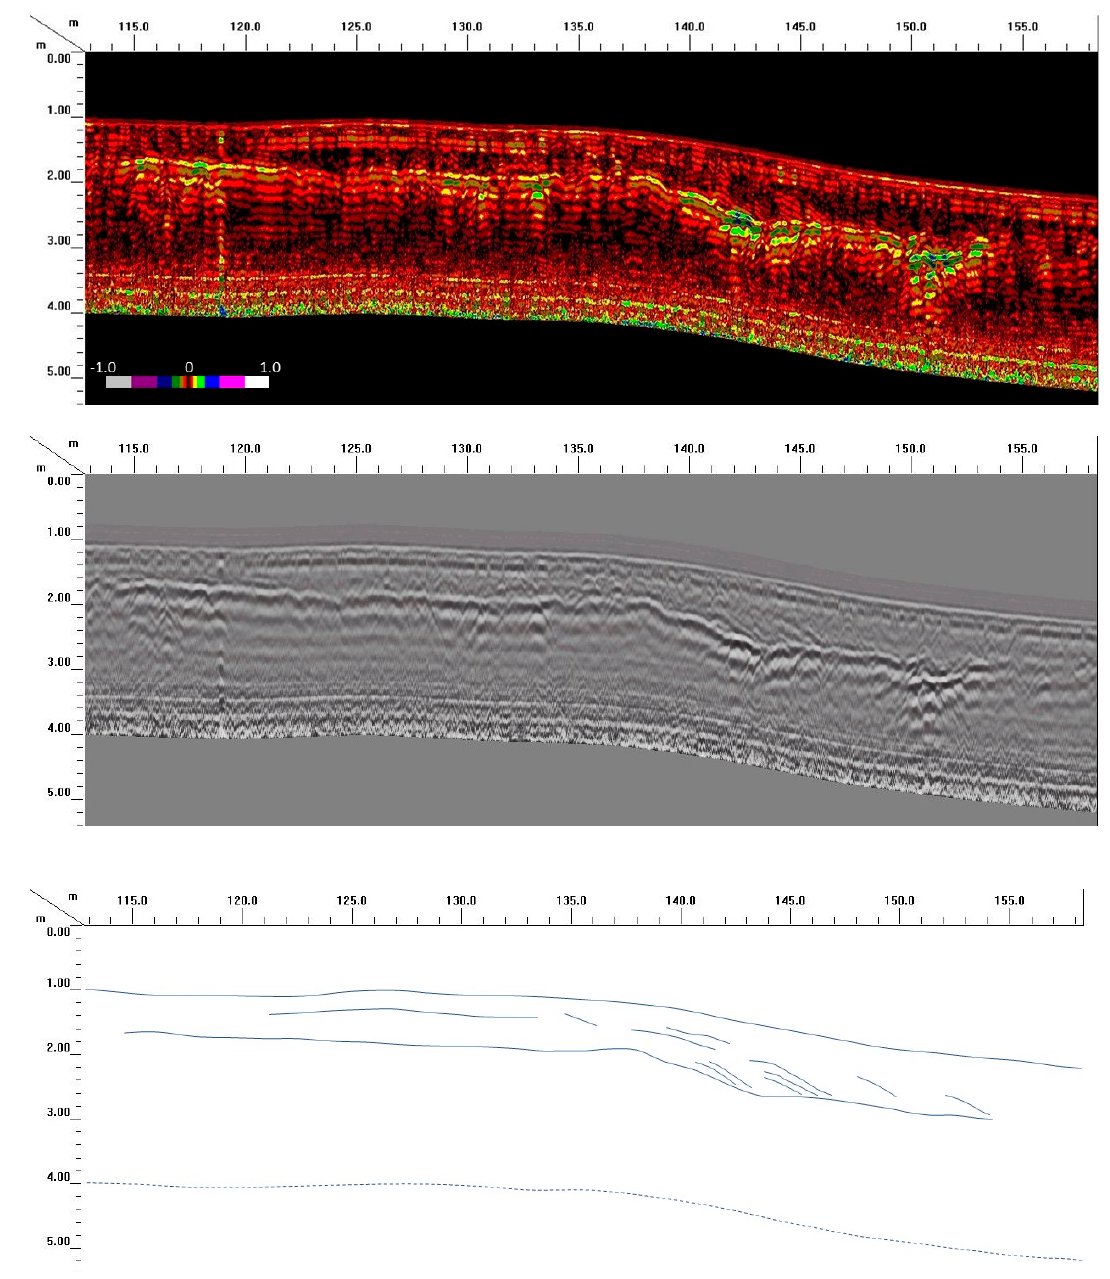
Figure 8. GPR profile and interpretation for the 1724 m shoreline. In the upper transect, data are presented with a color scale to highlight the normalized intensity of radar reflectors. The lower profile presents the same data in grayscale. In both profiles, landward is to the left and lakeward is to the right. Vertical exaggeration 3×.